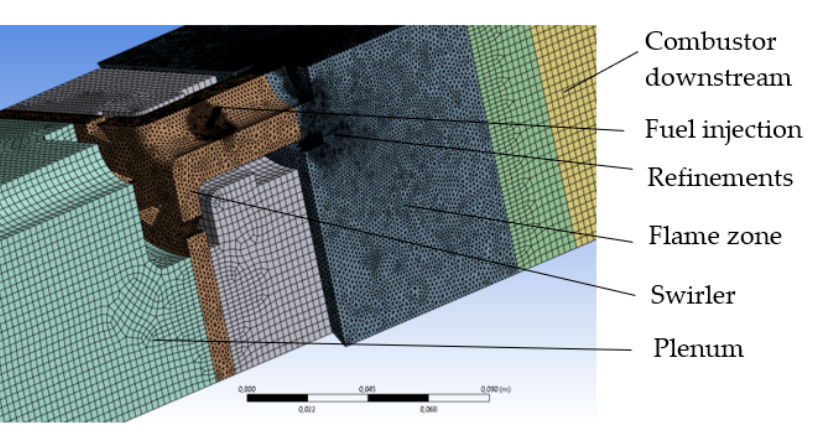
Figure 4. Mesh of a computational domain.